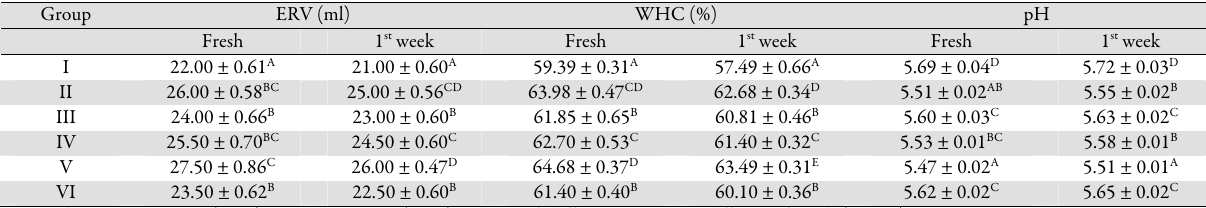
Table 2. Physico-chemical profiles of tissues of fresh and preserved broiler chicken meat fed with neem leaf and/or spirulina substituted diet